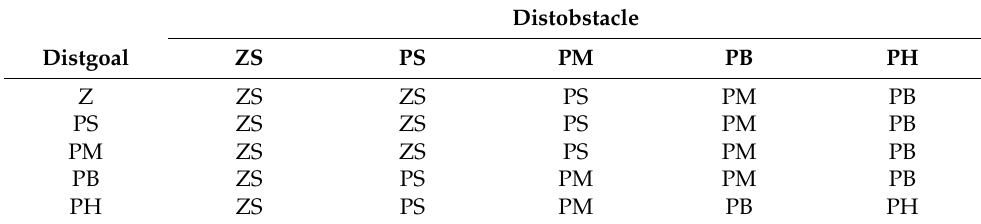
Table 4. Fuzzy control rules of Distgoal, Distobstacle, and ε speed .